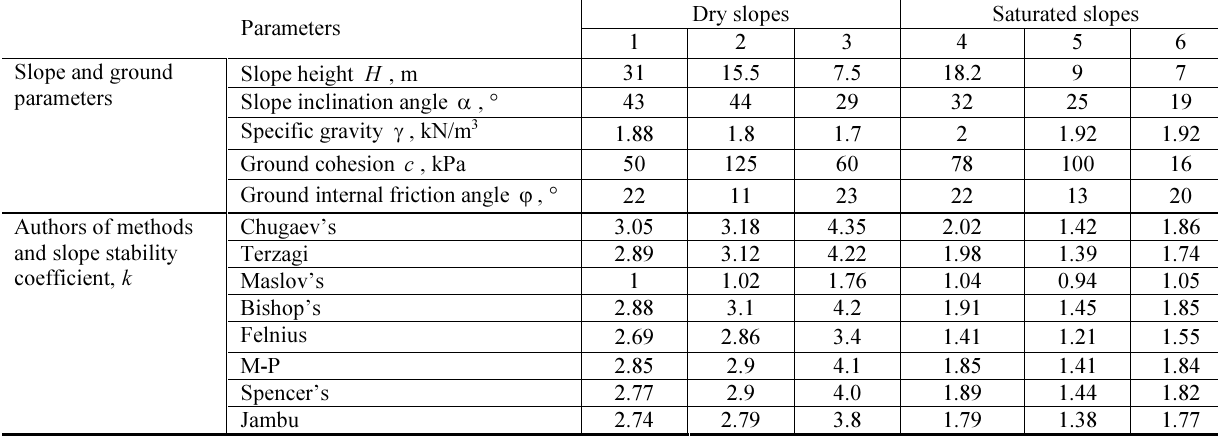
Table 2. Slope parameters and stability coefficients computed by different methods